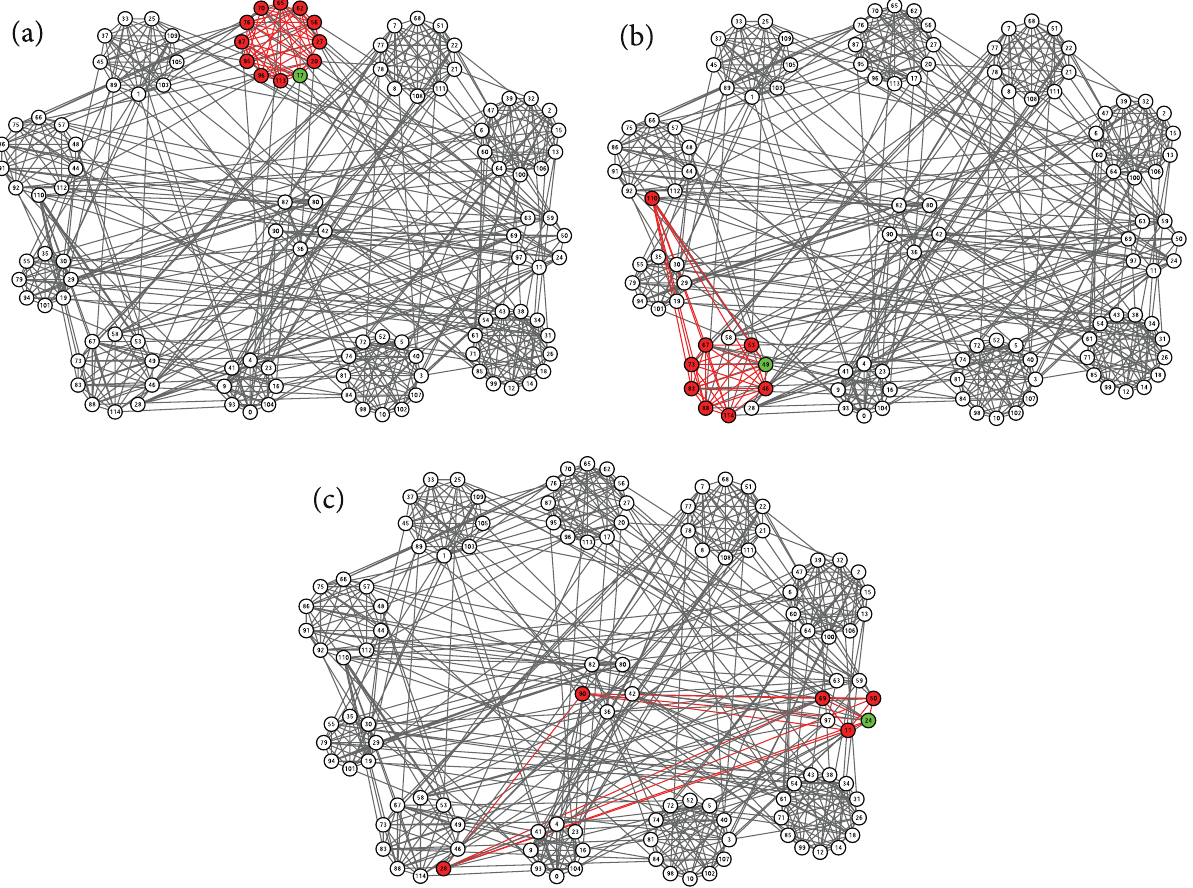
Figure 7. Identified local communities (red) of college football teams. Circles of nodes indicate the conferences of football teams. The five nodes placed in the middle represent five independent teams. Each of the subfigures shows the local clustering result generated by the proposed method, using seed nodes (green) 17, 49, and